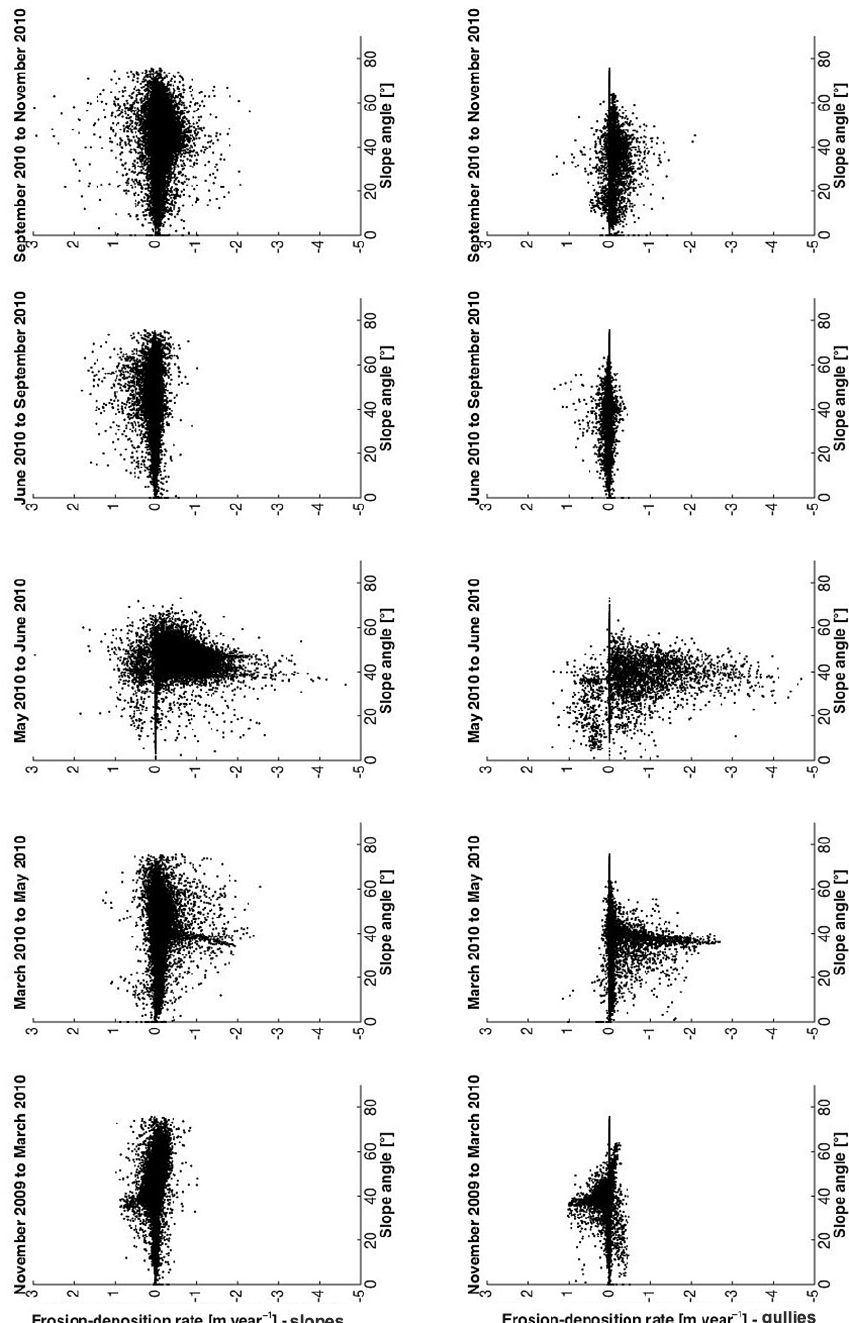
Figure 4. Vertical change over time vs. slope angle. Rates are calculated from a 10cm grid average of original DoDs and divided by the time separating the two lidar acquisitions. Slope angle in degrees, calculated in ArcGIS on a 10cm DEM of June 2010. Top graphs of the left column show rates for slopes and the right column for gullies and adjacent (20cm or closer) pixels (see the Supplement for similar graphs showing vertical change in absolute value vs. slope